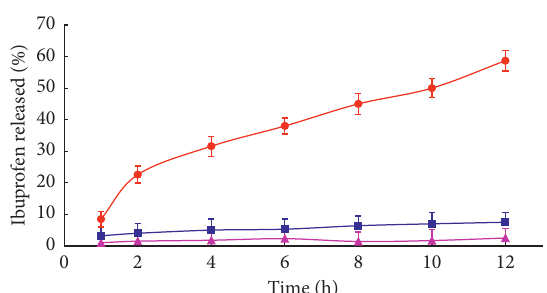
Figure 1: 13 C NMR of the ibuprofen- β -CyD-PEG